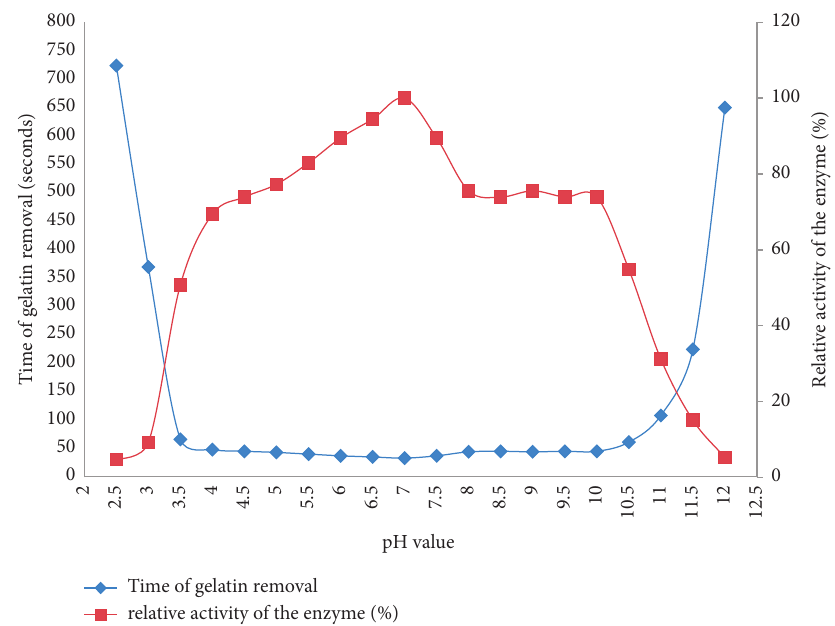
Figure 5: The effect of pH on enzyme activity (reaction mix 20 ml, i.e., 10ml buffer + 10 ml enzyme or 72U) at constant temperature of 70 ° C. Table 2: pH stability of the enzyme at different preincubation